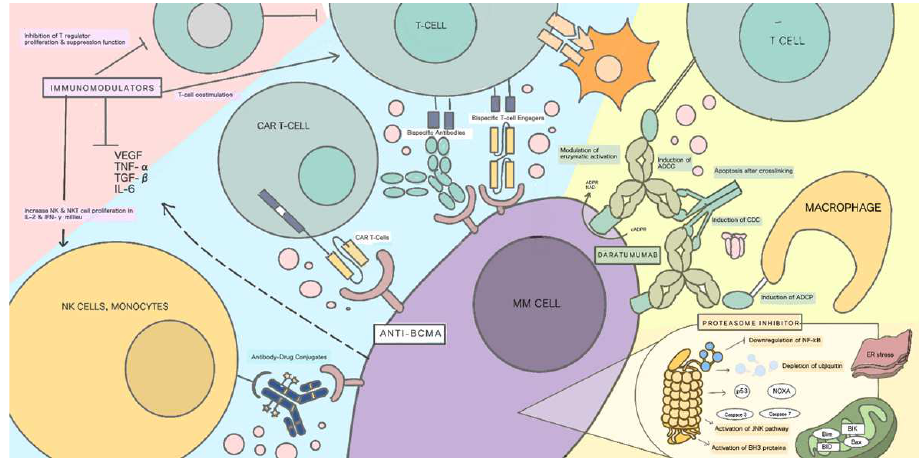
Figure 2. Known therapies for multiple myeloma and their mechanisms of action.